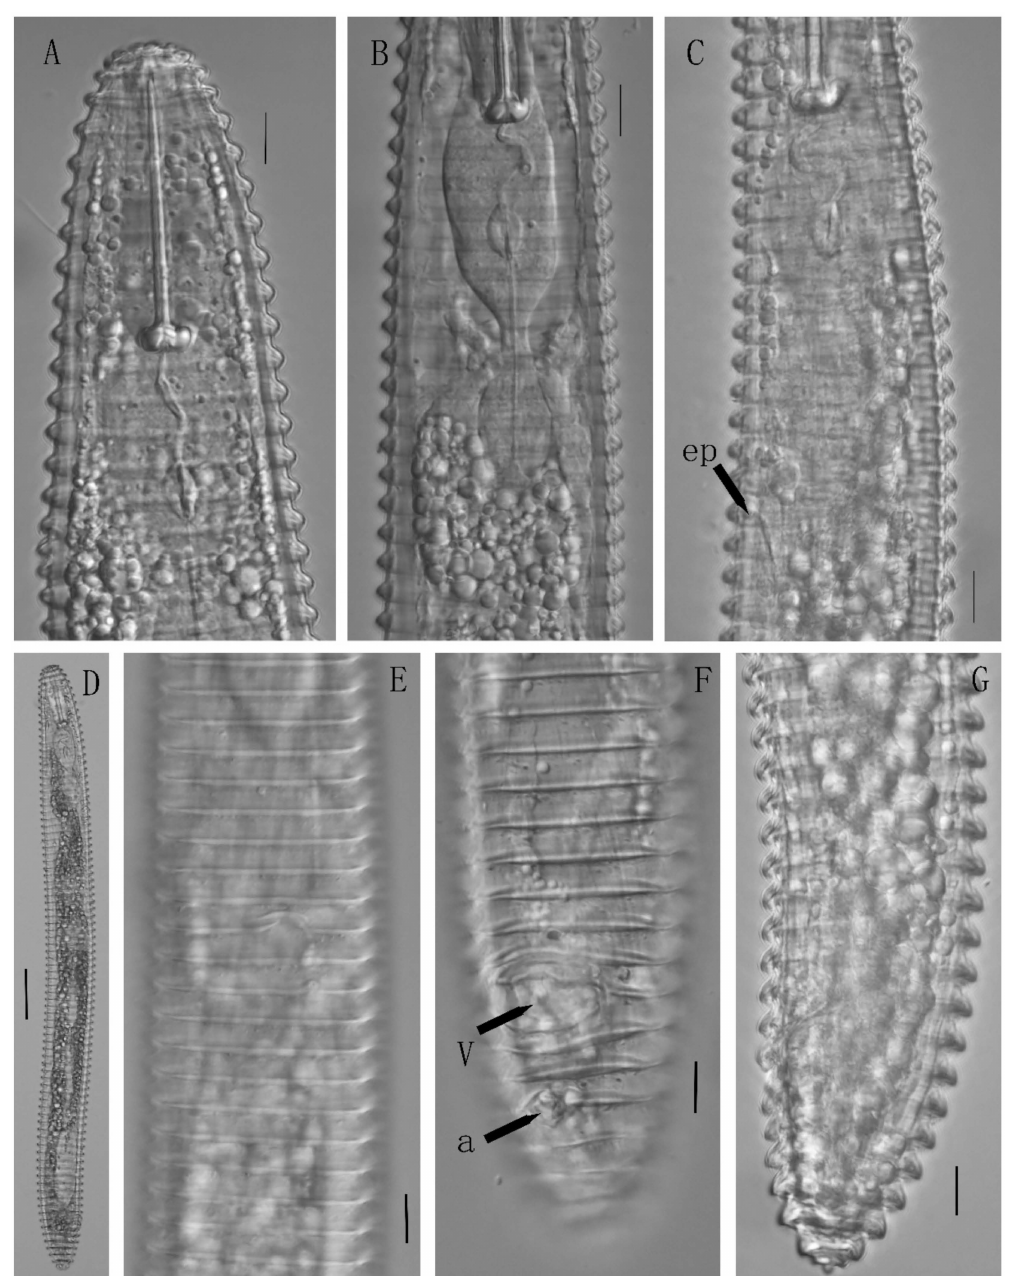
Figure 4. Adult female of Mesocriconema xenoplax . ( A ): Anterior body; ( B ): Esophagus; ( C ): Excretory pore (ep arrow); ( D ): Entire body; ( E ): Rings (annules); ( F ): Vulva (v arrow) and anus (a arrow); ( G ): Tail (Scale bars: ( D ) = 50 µ m; ( A – C , E – G ) = 10 µ m). Male : Similar to female in general. Testis single, outstretched. Spicules slightly curved ventrally, paired, separate. Gubernaculum well developed. Tail conoid and pointed. Bursa enveloping tail (Figure 5). Morphometrics : See Table